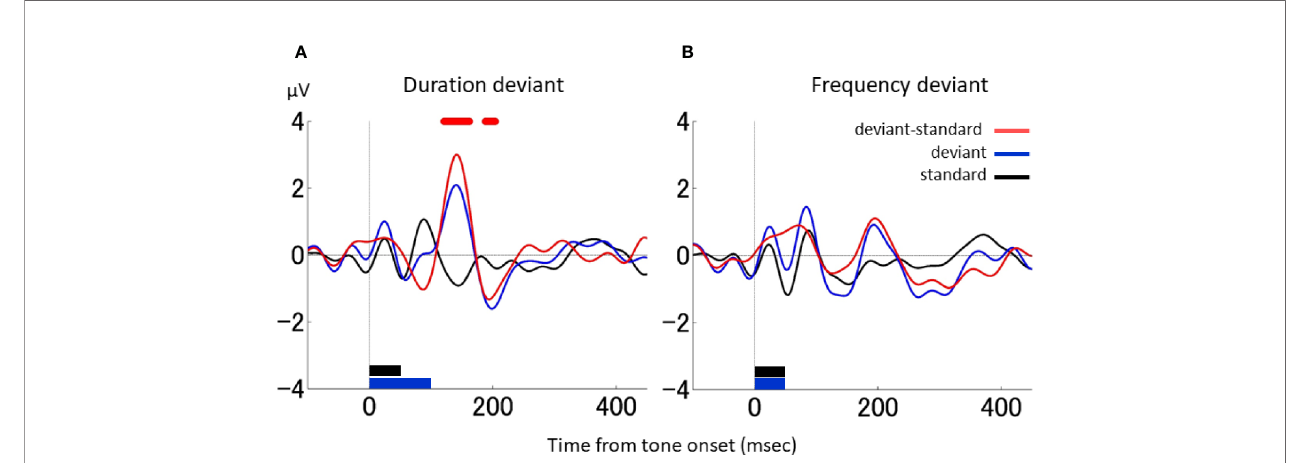
FIGURE 2 | dMMN and fMMN in macaque monkeys. (A) , Grand average waveforms in the duration-deviant experiment conducted on two macaque monkeys. The electrical potential is plotted as a function of the time from tone onset. The black line shows the responses to the standard stimulus, the blue line the responses to the deviant stimulus, and the red line the differential waveform. The stimulus duration (indicated at the bottom of the graph) was 50 ms for the standard stimulus (black) and 100 ms for the deviant stimulus (blue). The stimulus frequency was 1,000 Hz for both the standard and deviant stimuli. Red dots on the top of the graph denote the times at which the responses to the standard and deviant stimuli were statistically different (two-sample t test, p < 0.05, FDR corrected). (B) , Grand average waveforms in the frequency-deviant experiment conducted on two macaque monkeys. The stimulus frequency (shown at the bottom of the graph) was 50 ms for both the standard (black) and deviant (blue) stimuli. The stimulus frequency was 1,000 Hz for the standard stimulus and 1,200 Hz for the deviant stimulus. There were no statistical differences between the responses to the standard and deviant stimuli. The fi gure conventions are the same as in